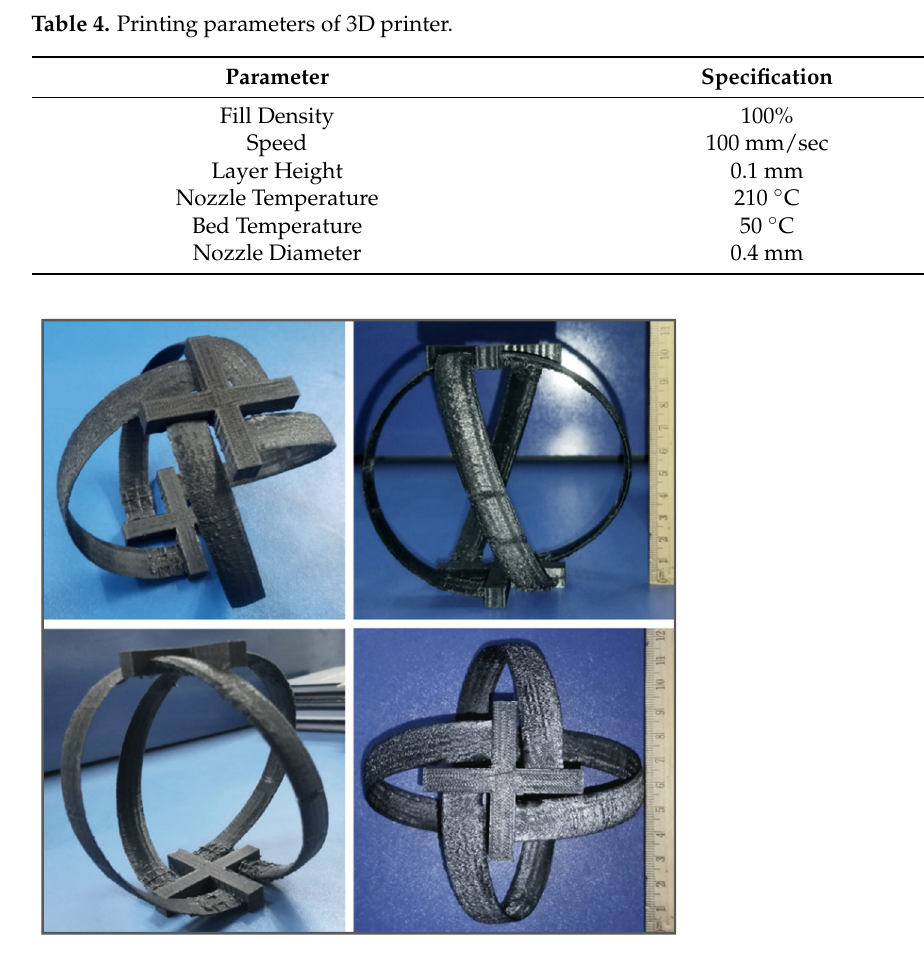
Figure 14. 3D model of the turbine obtained through 3D printing.